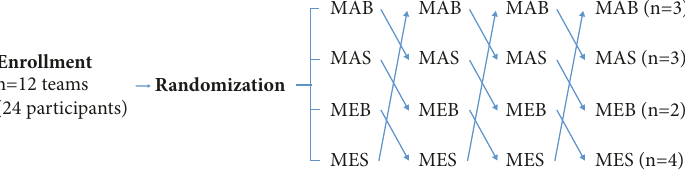
Figure 1: Experimental design. MAB, manual compressions with bag-valve mask ventilation; MAS, manual compression with supraglottic airway ventilation; MEB, mechanical compressions with bag-valve mask ventilation; MES, mechanical compressions with supraglottic airway